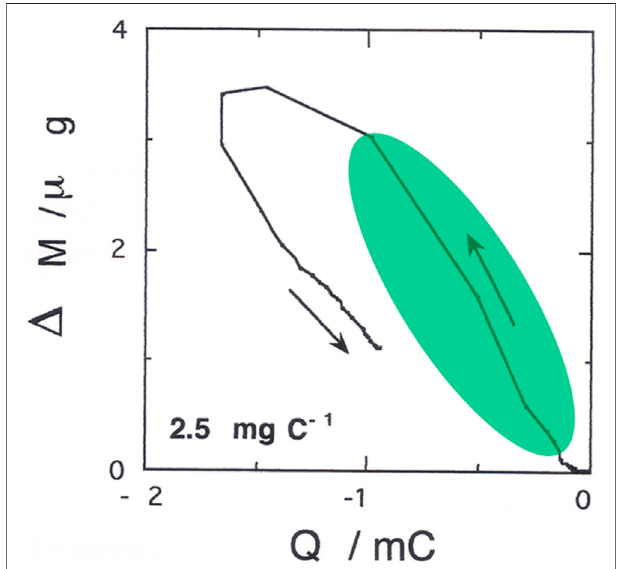
FIGURE 8 | Electrode mass variation ( Δ m ) with the charge ( Q ) exchangedduringthe fi rstcycleofpoly-3,3 ″ -DDTTelectrochemical n -doping. The applied potential range was − 2.5 ≤ E appl ≤ 0 V vs. Ag/Ag + similar to what has been reported in (Naoi et al., 1991). The value of 2.5 mg C − 1 in the inset represents the slope of the linear portion evidenced in light green on the